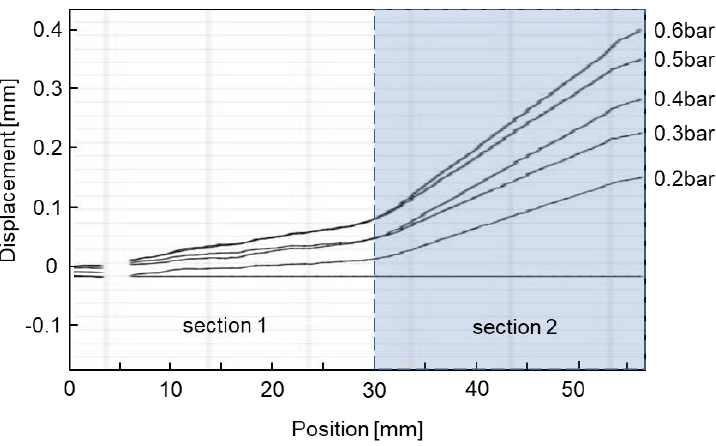
Figure 13. Top) Schematic view of a lip segment; Bottom) Displacement along the lip segment measured with a digital image correlation (DIC)-system at a plenum pressure of 0.6 bar.